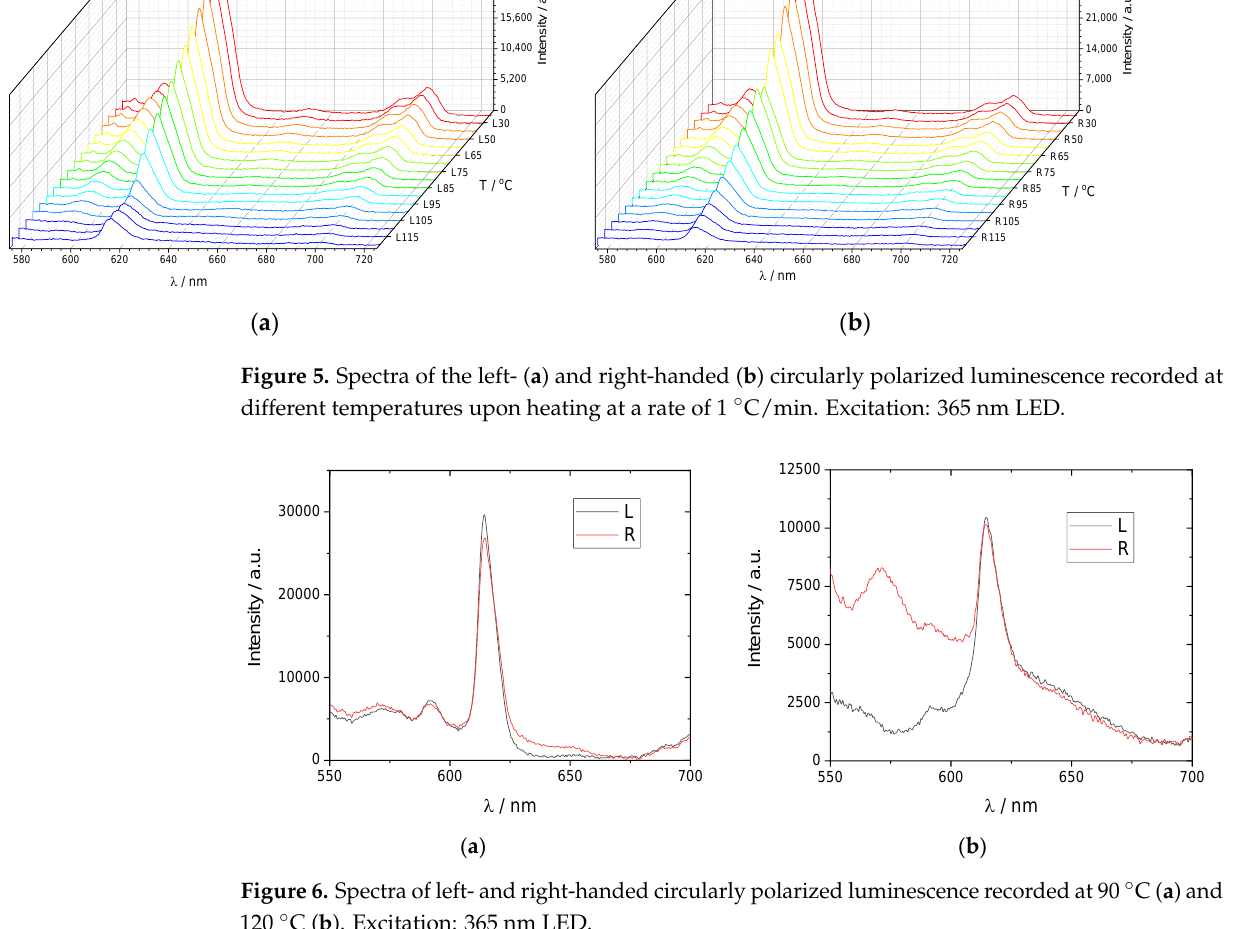
Figure 4. Photographs of the mixture film prepared by the Dr. Blade technique at 120 °C taken under the UV light and daylight at different temperatures. The sample was quenched or slowly cooled down (1 °C/min). Photographs were taken under oblique viewing (40 – 60°). The width of the image is ca. 5 mm.